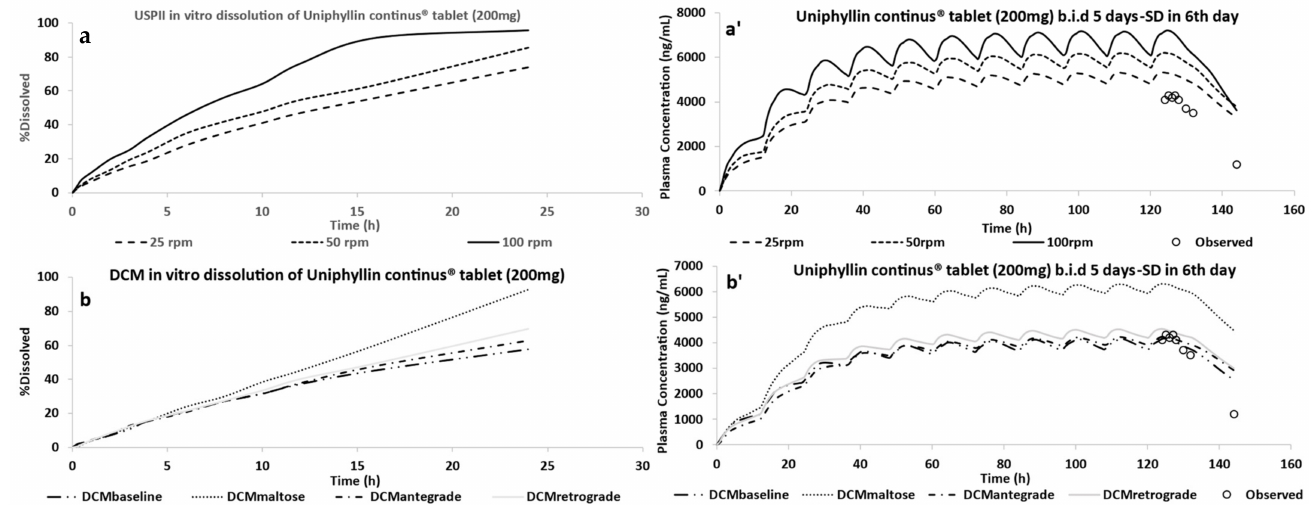
Figure 3. Average in vitro dissolution profiles of the Uniphyllin Continus ® tablet (200 mg) in the USP II ( a ) and DCM ( b ) and the corresponding predictions ( a’ , b’ ) of the plasma concentration of theophylline after administration of Uniphyllin Continus ® tablet (200 mg) twice daily (b.i.d) for 5 days, with a single dose (SD) on day 6 [41]. Dissolution testing applied agitation speeds of 25, 50 and 100 rpm were used in the USP II and four motility patterns were used in the DCM, as detailed in O’Farrell et al.